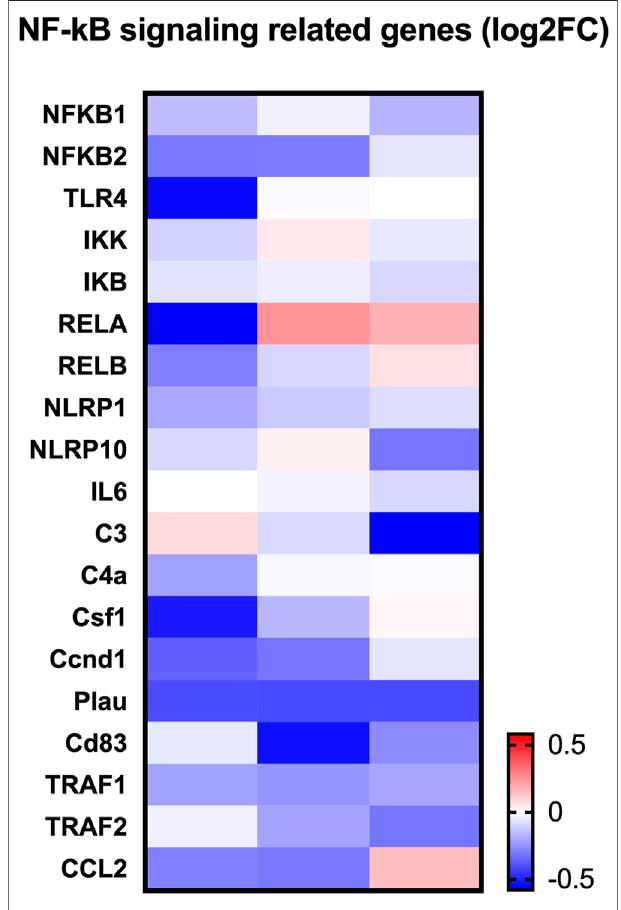
FIGURE 6 | Heatmap showed expression change of NF- κ B related genes between LINC02569 knockdown group and negative control group in NPCs from